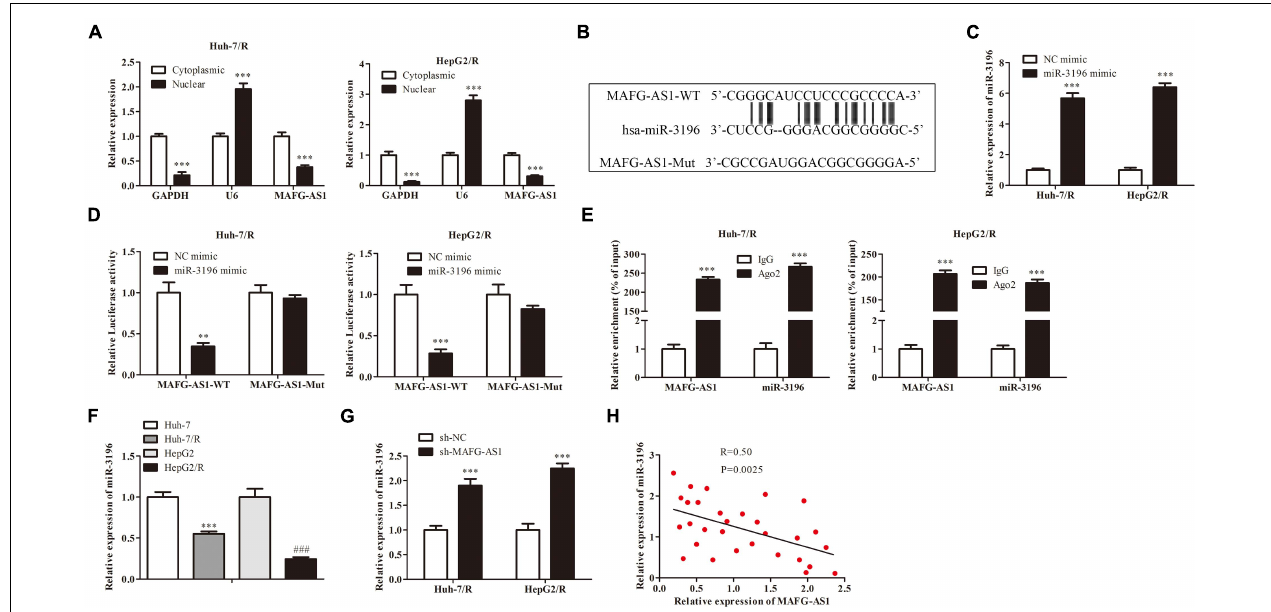
FIGURE 3 | miR-3196 bound with MAFG-AS1. (A) RNA-FISH assay implied the location of MAFG-AS1. *** P < 0.001 vs cytoplasmic group. (B) Schematic diagram demonstrated the complementarybinding within miR-3196 and MAFG-AS1 3 (cid:48) -UTR with binding sites predicted by bioinformatics programs (StarBase V 2.0, http://starbase.sysu.edu.cn/mirLncRNA). (C) RT-PCR analysis was used to verify the efficiency. *** P < 0.001 vs NC-mimic group. (D) Lucife rase reporter gene assay was performed in Huh7/R and HepG2/R cells transfected with MAFG-AS1 wild/mutant type and miR-3196 mimics/control. ** P < 0.01, *** P < 0.001